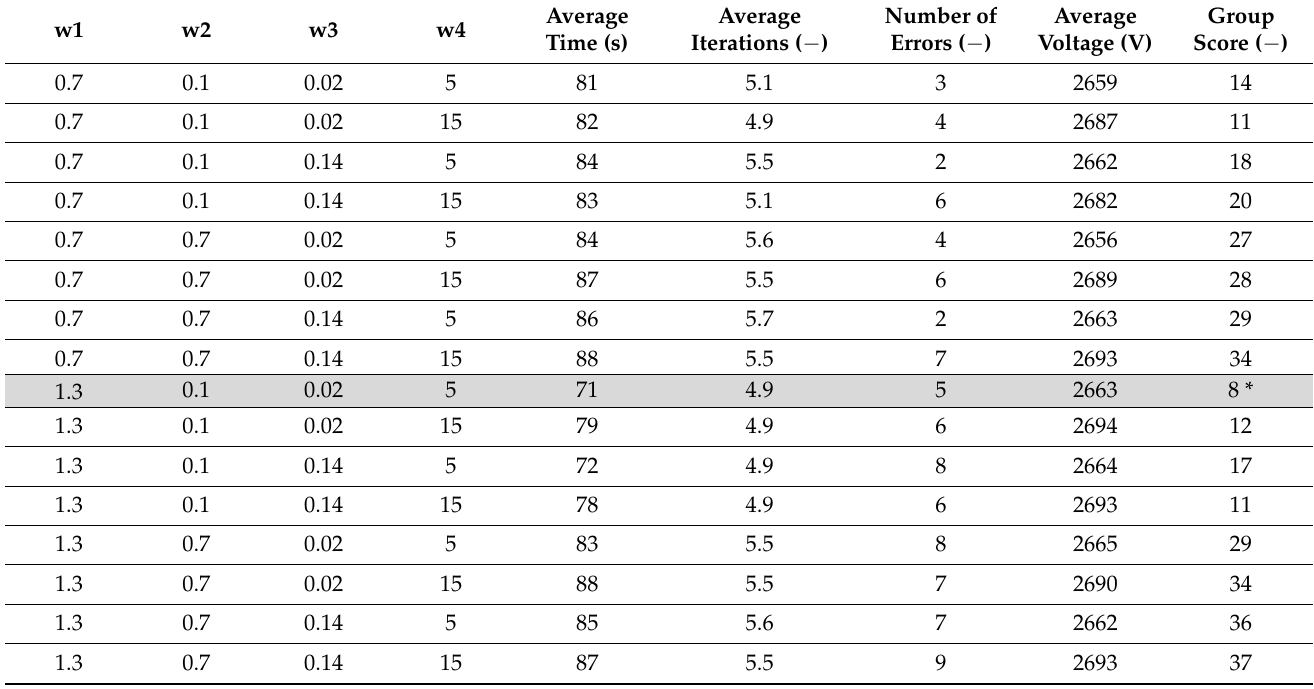
Table 2. Results of the full factorial experiments for weights